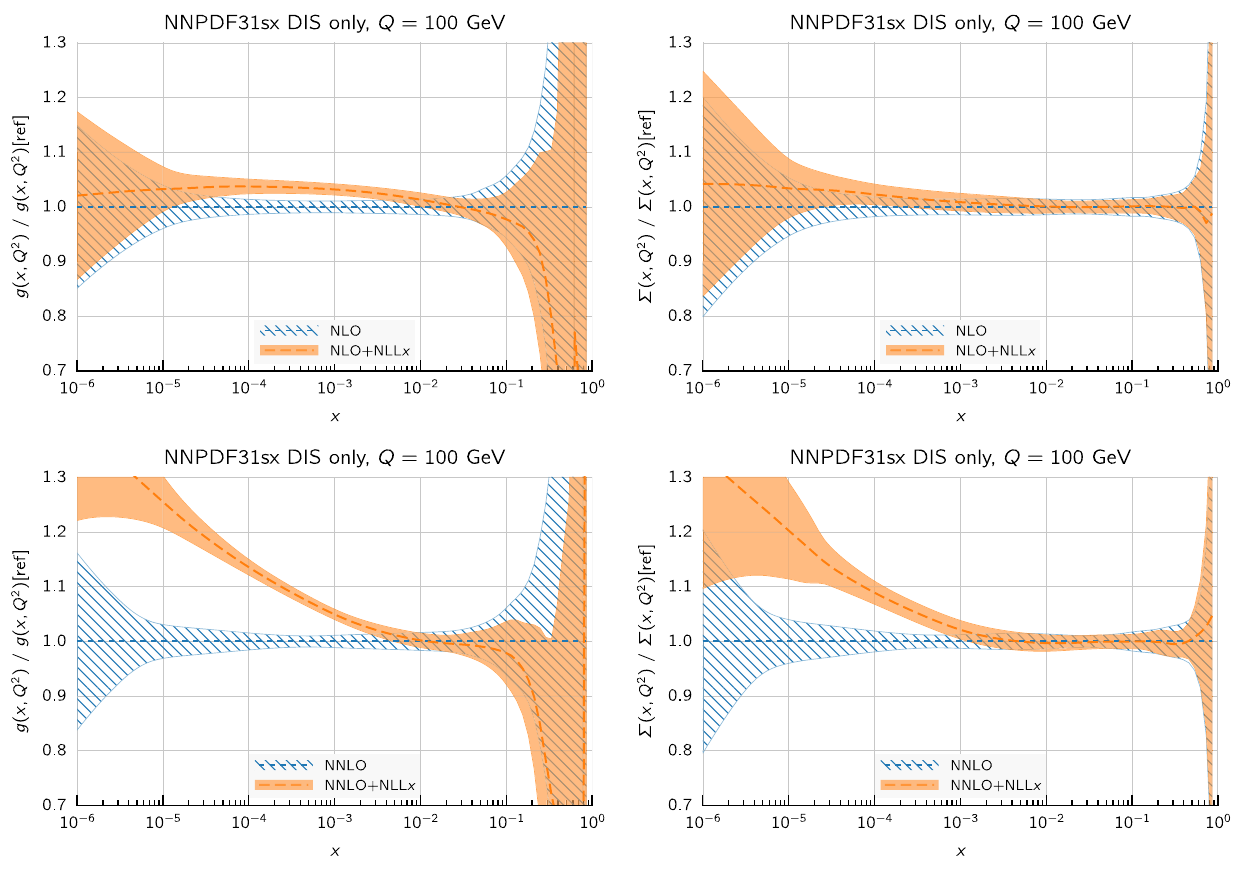
Fig. 8 Comparison between the gluon (left) and the total quark singlet (right plots) from the NLO and NLO+NLL x (upper plots) and from the NNLO and NNLO+NLL x DIS-only fits (lower plots). The com-